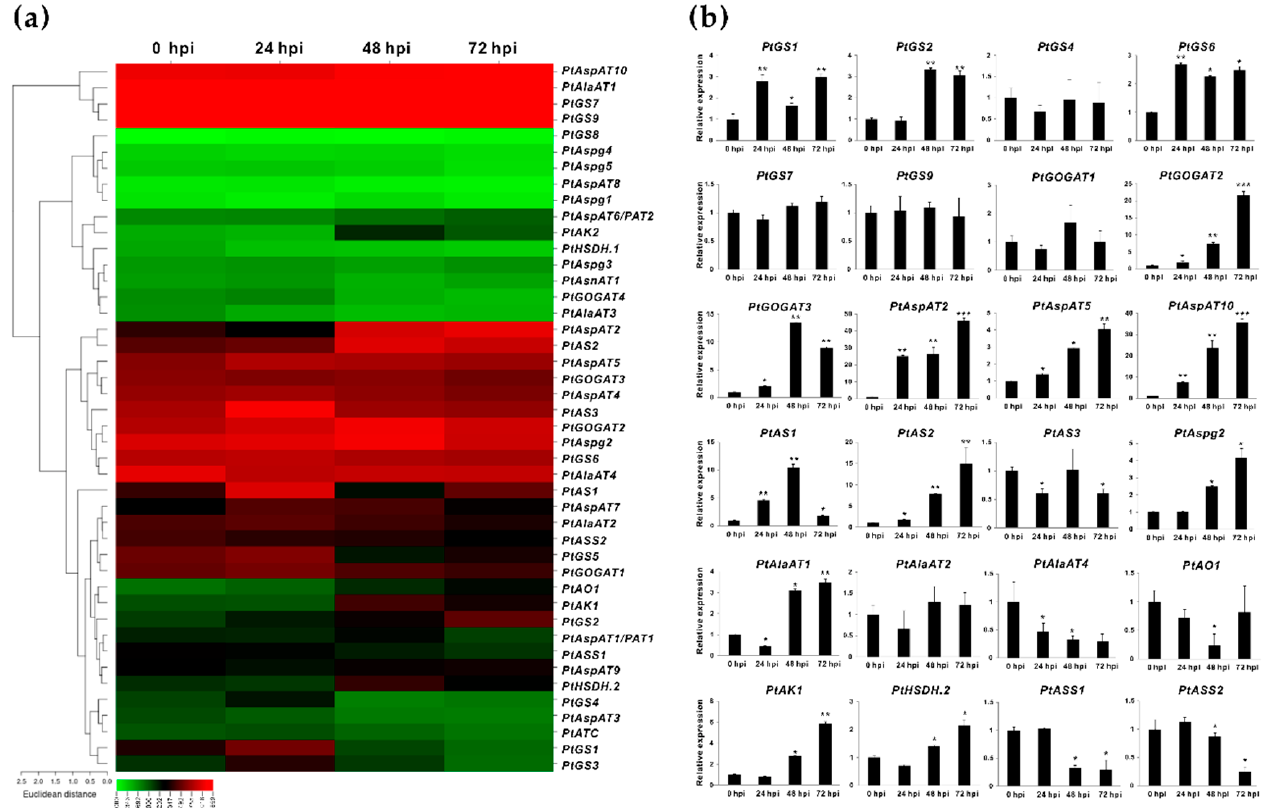
Figure 4. Effects of isogene expression at the time-courses of Fs infection in roots. ( a ) The heatmap shows the transcriptomic profile of isogenes in Fs infected roots (0, 24, 48, and 72 h of post-inoculation, hpi). ( b ) Validation of responsive isogenes compared to the control (0 hpi) by qRT-PCR. The RNA-seq results were given in the Log (FPKM) expression values. PtActin , PtUBIC , and PtEF- α 1 were set up as the internal control. Data represent mean values standard error (±SE) of at least three independent biological replicates. The asterisks indicate significant differences relative to the control using Student’s t -test: *** p < 0.001, ** p < 0.01, and * p < 0.05.